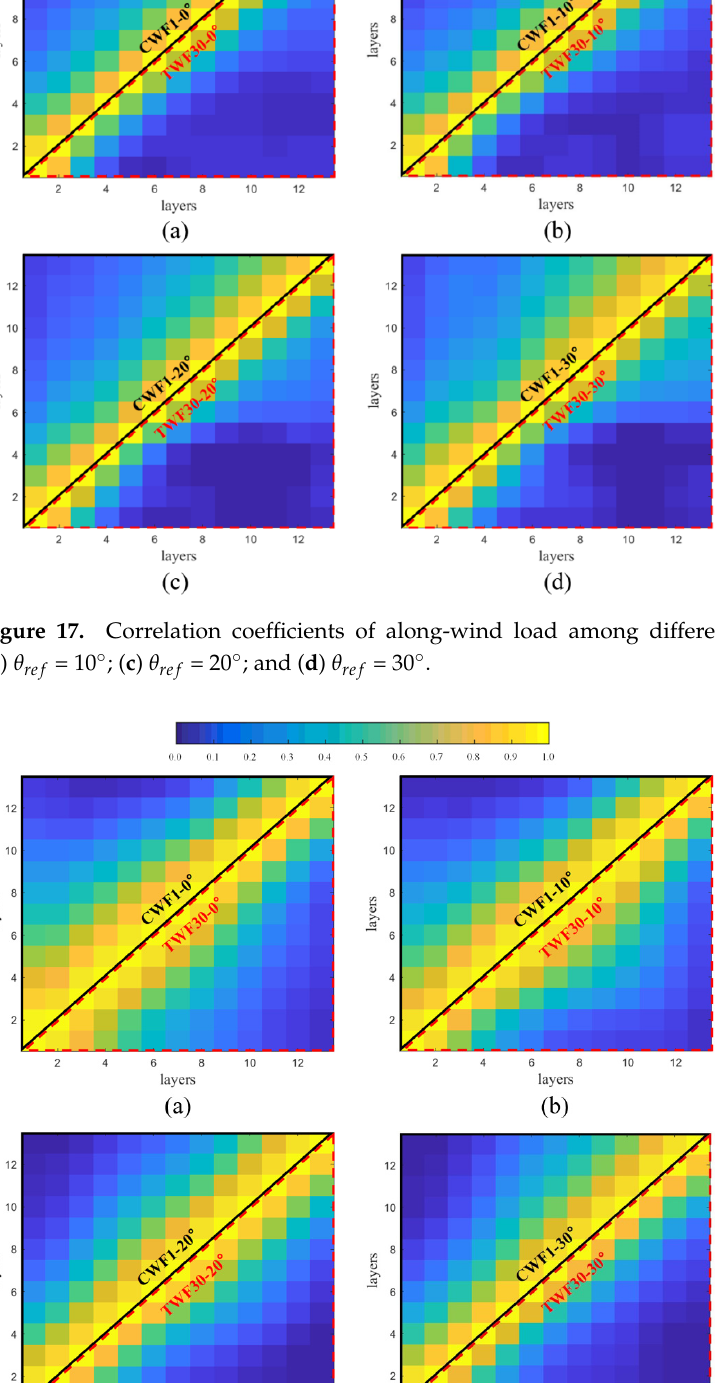
Figure 19. Correlation coefficients of ( a ) along-wind load and ( b ) across-wind load among different layers in the case of 𝜃 (cid:3045)(cid:3032)(cid:3033) = 0°.